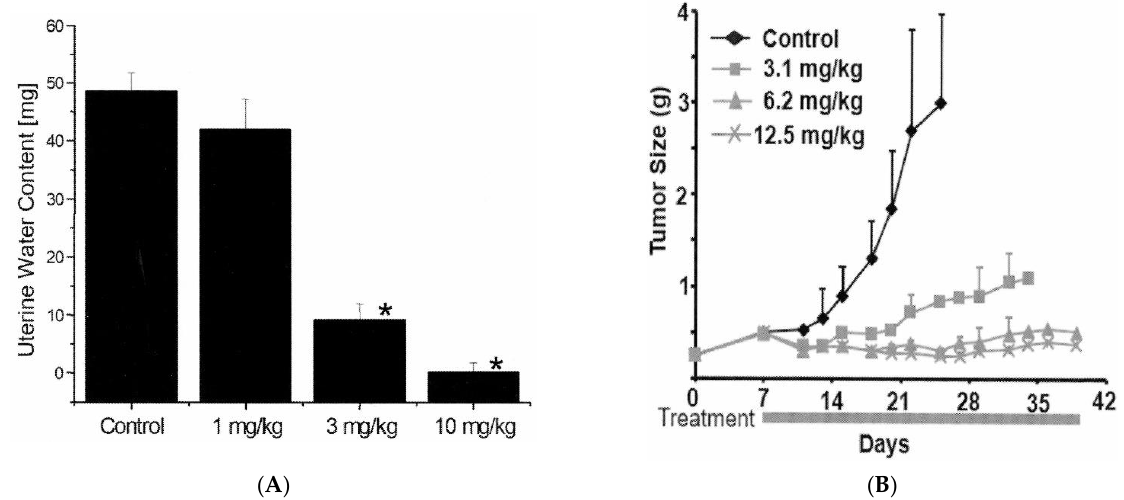
Figure 1. In vivo pharmacology of ABT-123. ( A ) Inhibition of uterine edema in mice by ABT-123. Mice ( n = six per group) were orally administered ABT-123 or vehicle 30 min prior to an i.p. injection of 25 μ g estradiol. The uterus was removed 2.5 h following estradiol stimulation. The uterine water content was expressed as the difference between wet and blotted uterine weights. ABT-123 induced a statistically significant decrease (* p < 0.01) in mean water content at 3 and 10 mg/kg. ( B ) Effects of ABT-123 on the growth of HT1080 human tumor cells implanted subcutaneously in the flank of severe combined immunodeficiency disorder mice. Mice ( n = ten per group) were dosed with ABT-123 or vehicle daily starting on Day seven. Tumor volumes are expressed as mean ± SD. Statistically significant differences ( p < 0.05) in mean tumor volume were observed for all treatment groups by Day fourteen. Table 1. Kinase inhibition profile of ABT-123.